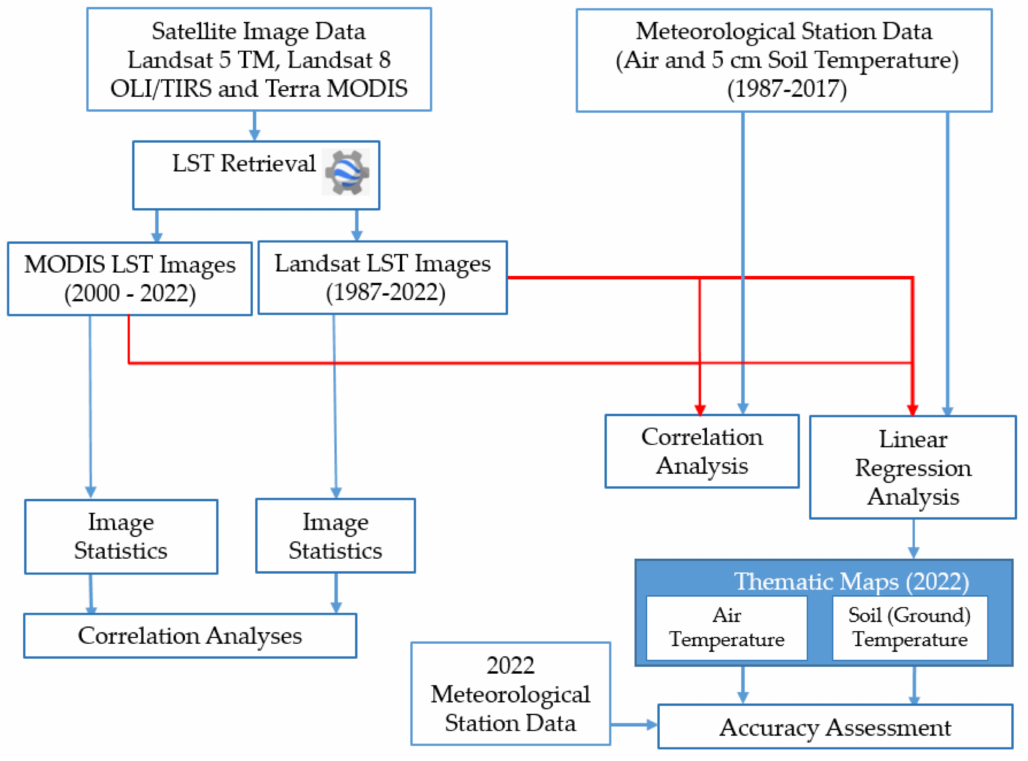
Figure 3. The flow chart of the